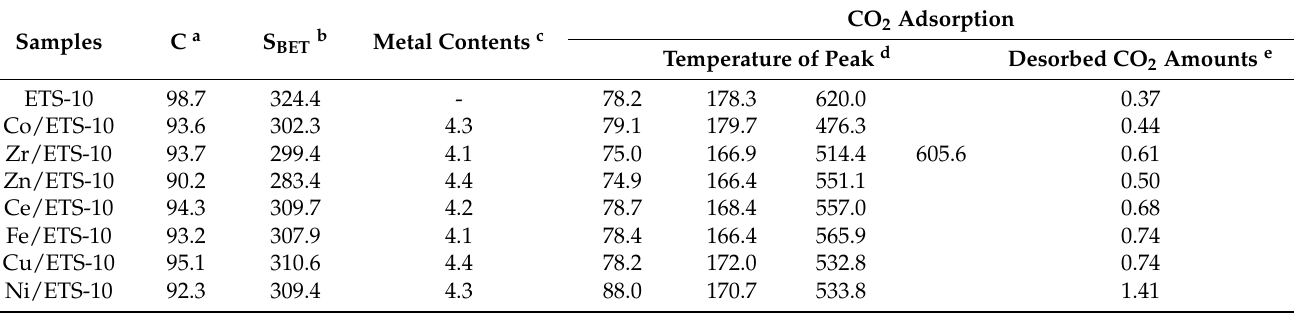
Figure 1. ( a ) XRD patterns and ( b ) CO 2 -TPD profiles of different ETS-10 zeolite-based catalysts. Table 1. Physicochemical properties of different ETS-10 zeolite-based samples.